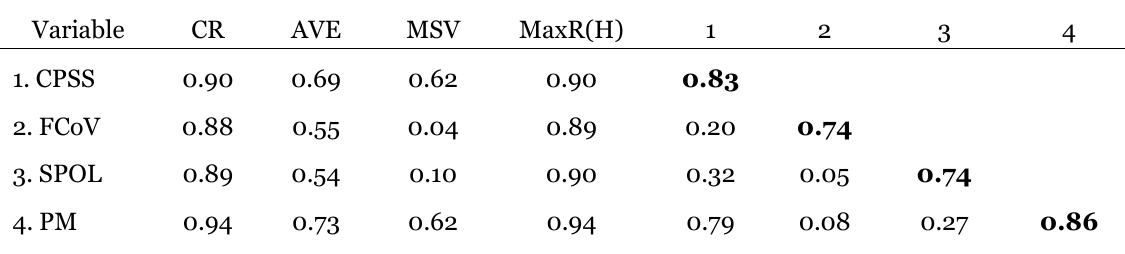
Overall Reliability and Validity of the Constructs